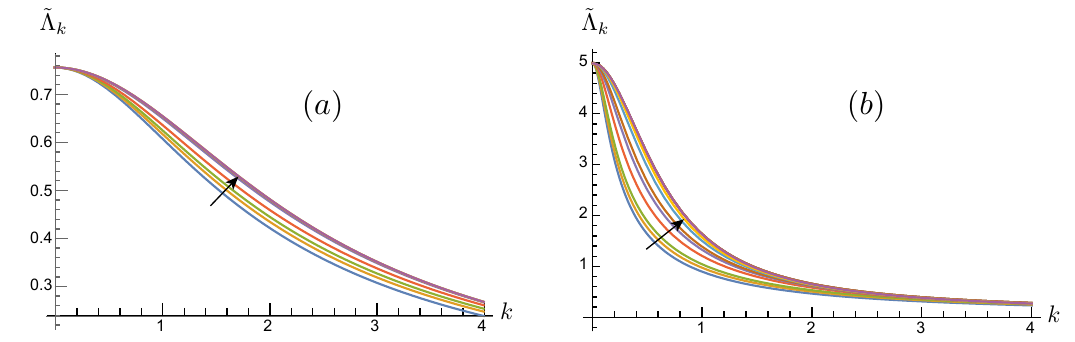
= ˜ Λ Figure 9: Λ vs k for various values of z between 0 and 20 in D = 1. The K , z k arrows point towards the direction of increasing z . (a) α = 1, ζ = − 0.1 and σ = 2.01 (b) α = 1, ζ = 0.1 and σ = 0.01. The curves converge to a universal one in the large z limit.